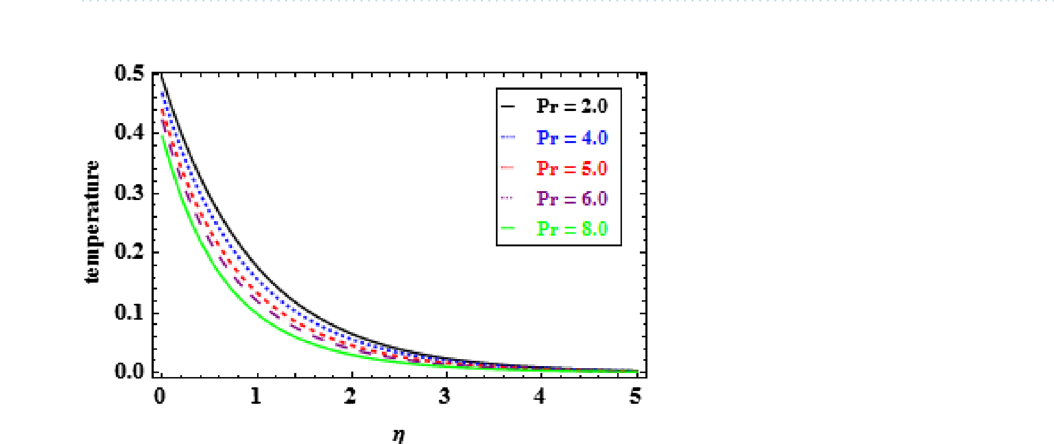
Figure 11. Inspiration of N r on temperature.